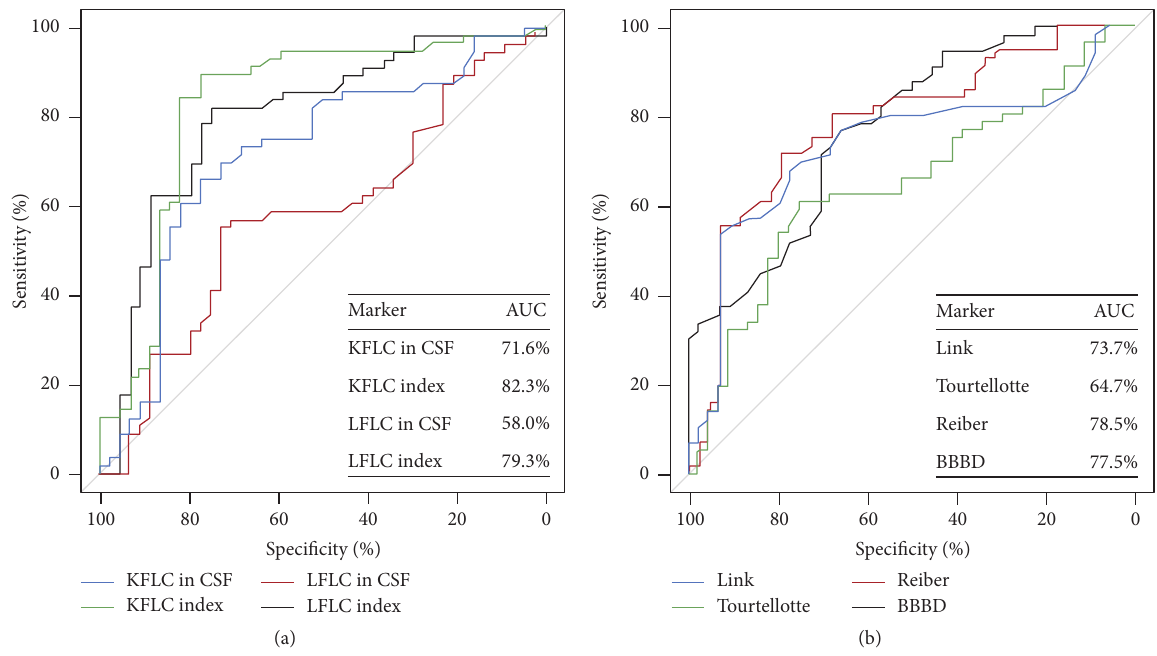
Figure 2: Receiver operator characteristic (ROC) curves of free light chain (a) and CSF standard indices (b) in multiple sclerosis (MS) and clinically isolated syndrome suggestive of MS